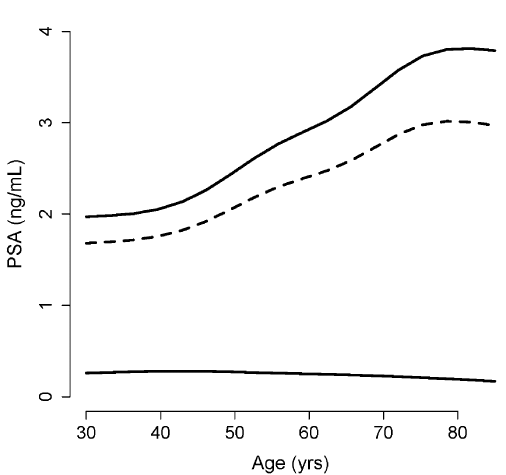
Figure 1. Histograms of the relative frequency distribution of Ln(PSA) for (A) those aged ≥ 20 years, (B) ≥ 65, and (C) 54–59 years. In each panel, the orange solid curve is the binormal curve fitted to the data (the histogram representing the relative frequency). The curve is in fact the result of superposition of two normal curves describing the relative frequency distribution of Ln(PSA) in non-diseased individuals (blue dashed curve) and diseased patients (magenta dashed curve). Vertical green solid lines bound the reference range for PSA.